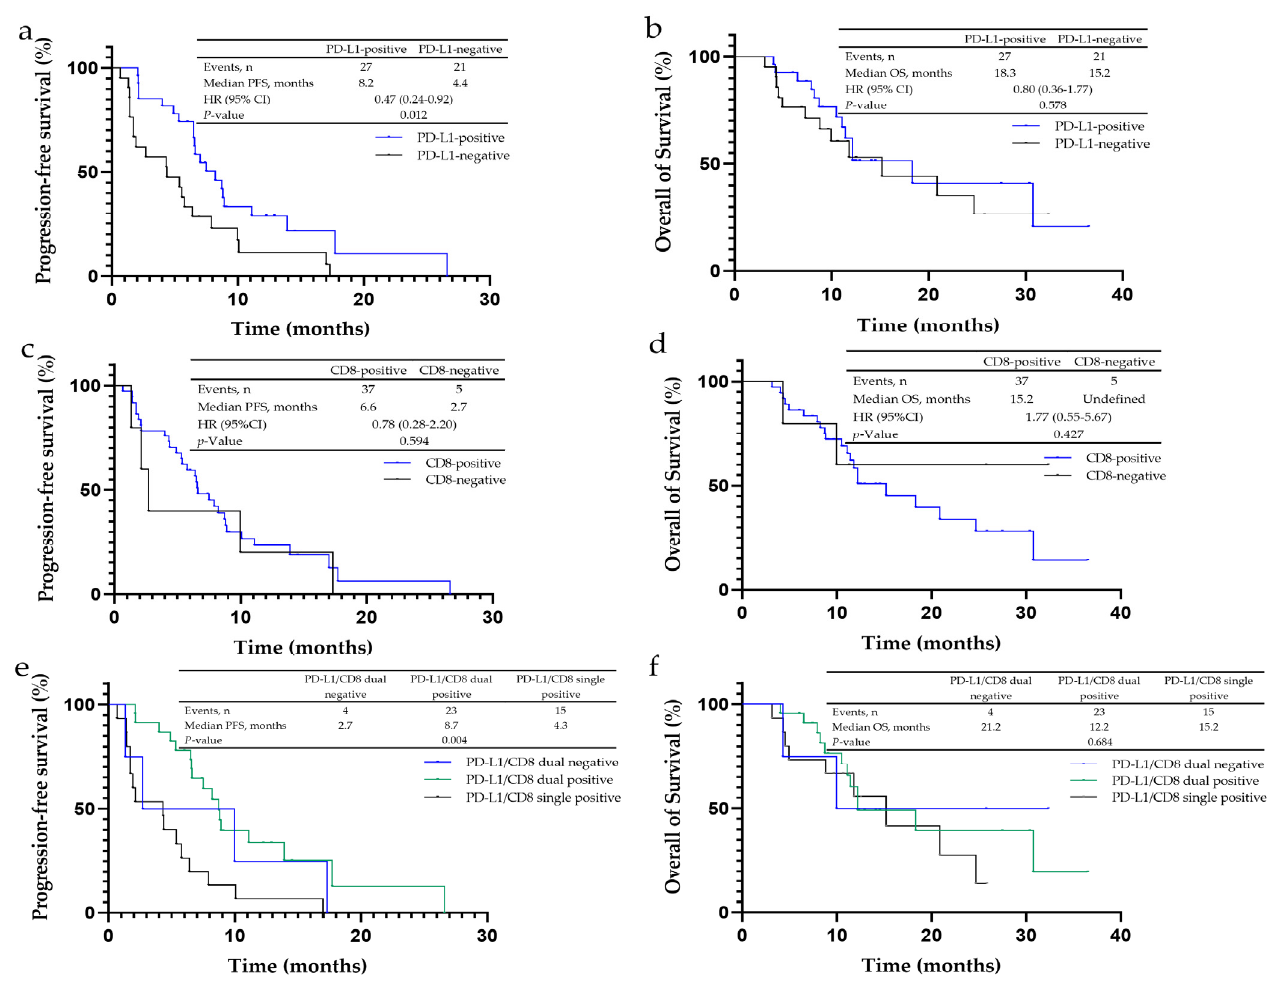
Figure 2. Kaplan–Meier analysis for progression-free survival (PFS) and overall survival (OS) in non-small cell lung cancer (NSCLC) patients with liver metastases to PD-L1, CD4+, CD8+ and CD68+ expression. ( a ) The median PFS of PD-L1-negative cancer was 4.4 months, and that of PD-L1-positive cancer was 8.2 months. ( b ) The median OS of PD-L1-negative cancer was 15.2 months, and that of PD-L1-positive cancer was 18.3 months. ( c ) The median PFS of CD8-negative cancer was 2.7 months, and that of CD8-positive cancer was 6.6 months. ( d ) The median OS of CD8-negative cancer was undefined, and that of CD8-positive cancer was 15.2 months. ( e ) The median PFS of PD-L1/CD8-dual-negative cancer was 2.7 months, that of PD-L1/CD8-dual-positive cancer was 8.7 months, and that of PD-L1/CD8-single-positive cancer was 4.3 months. ( f ) The median OS of PD-L1/CD8-dual-negative cancer was 21.2 months, that of PD-L1/CD8-dual-positive cancer was 12.2 months, and that of PD-L1/CD8-single-positive cancer was 15.2 months.